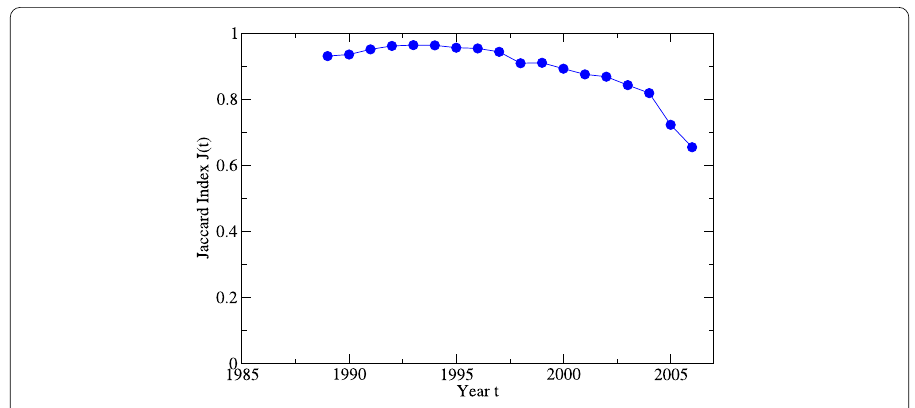
Figure 24 Jaccard index for the link sets V ( t ) of the data, defined as J ( t ) = | V ( t ) ∩ V ( t + 1) | / | V ( t ) ∪ V ( t + 1) | . The solid line corresponds to the points ( t o , J ( t o )),( t o + 1, J ( t o + 1)), ... ,( t f – 1, J ( t f –